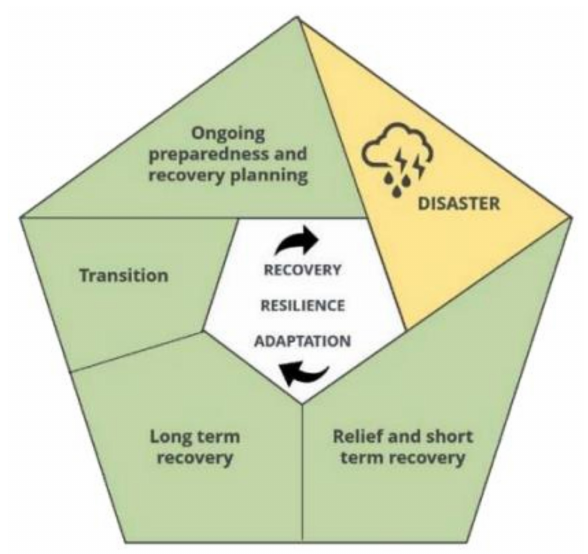
Figure 1. The recovery cycle from the Australian Royal Commission into National Disaster Arrange- ments 2020 [91], used under a Creative Commons Attribution 4.0 International